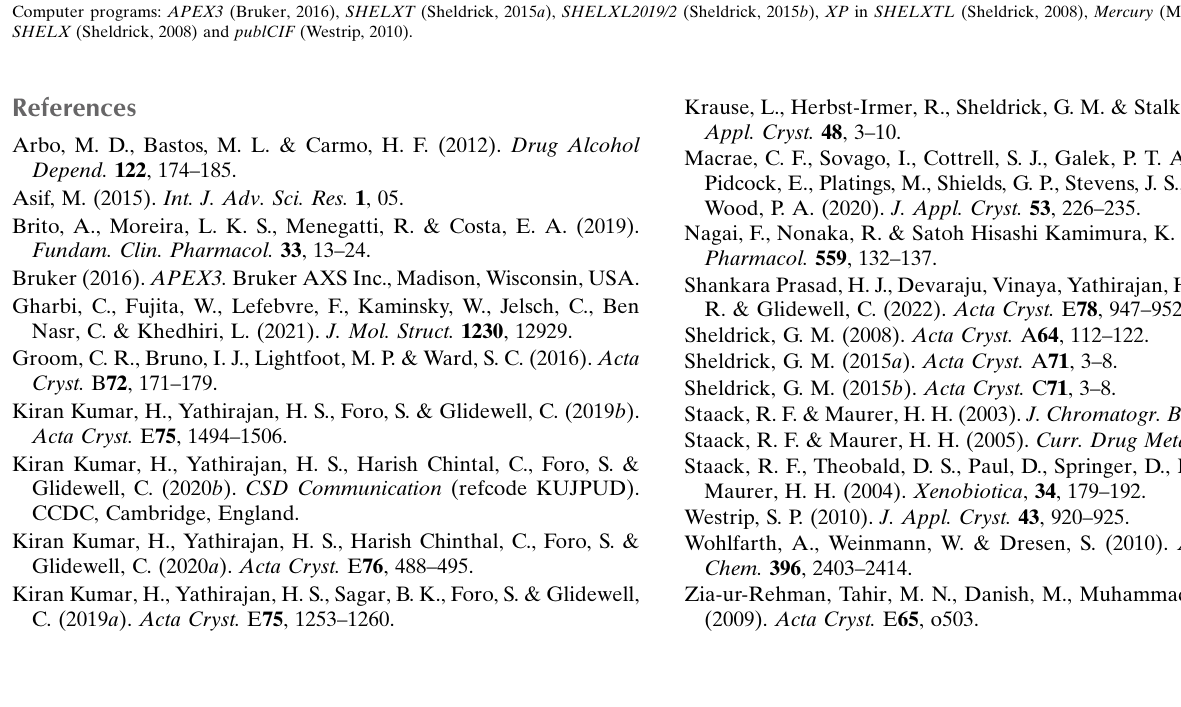
Crystal data Chemical formula